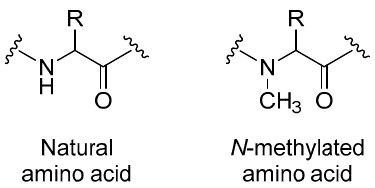
Figure 13. Structures of natural compared to N -methylated amino acids.